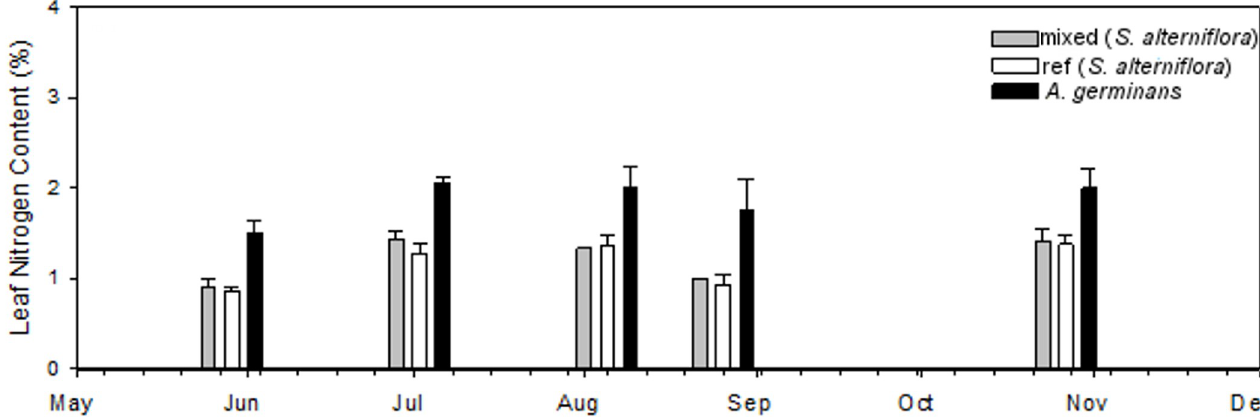
Fig 4. Percent nitrogen (%N) leaf content in 2013 for all treatments. S . alterniflora -mixed %N did not vary significantly from S . alterniflora -ref %N (p = 0.055), and A . germinans %N was greater than S . alterniflora -mixed %N (p < 0.004) and S . alterniflora -ref (p < 0.002). https://doi.org/10.1371/journal.pone.0210144.g004 species. There is a greater mass per unit area in A . germinans leaves than in S . alterniflora leaves, but the overall effect of herbivory on either plant species is small. If herbivores are 100% responsible for the missing areas, they are still only removing < 5% of leaf area in cordgrass and < 1% of leaf area in mangroves, but this does not account for entire leaves that are removed from the plants. No published studies quantifying herbivory on A . germinans along the nGOM could be found, but in warmer climates, higher rates of herbivory were observed on A . germinans (0.83–4.5% of leaf area in Guadeloupe [28]; 8–36% in Belize [27]). Alongi [48]